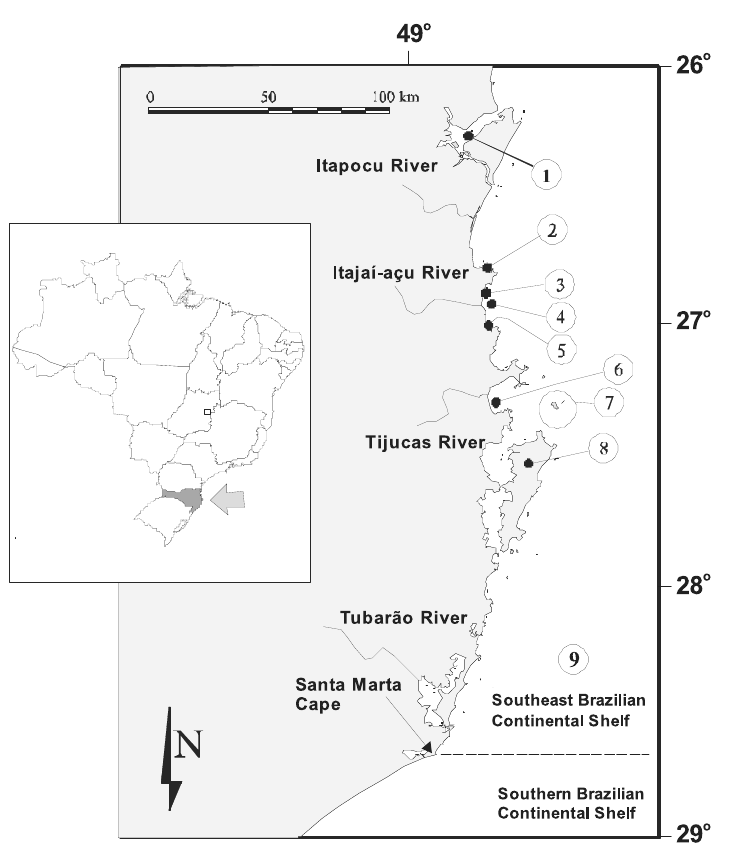
environments in which the samplings of zooplankton were collected (Table I). It also shows the identification of the rivers, and division of the continental shelf at Santa Marta